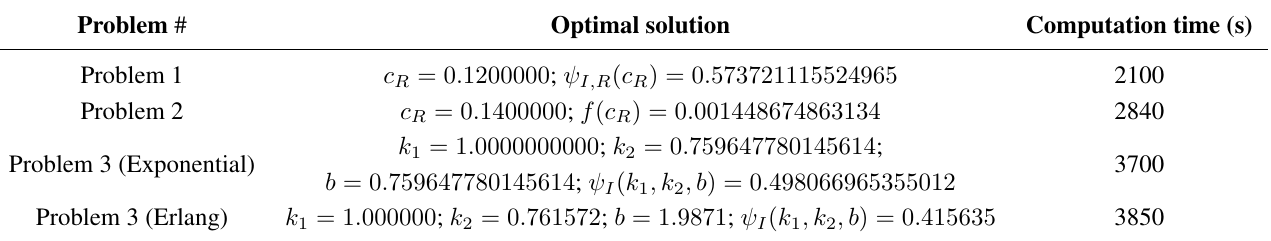
Table 4. Exact solutions (inspection-based